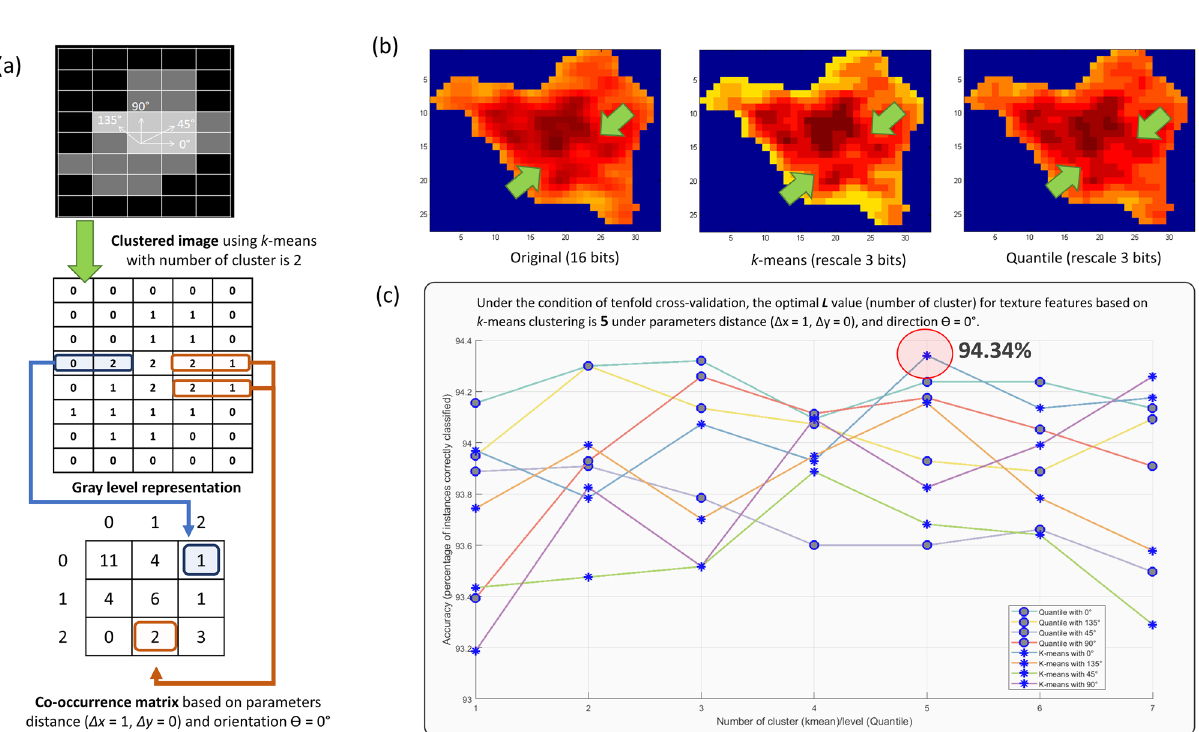
Figure 6. ( a ) Geometrical relationship of GLCM computed based on distance d = 1 and four directions, where Ɵ = 0°, 45° 90°, and 135°. ( b ) The result of texture visualization after rescaling the intensity information from 16 to 3 bits through k -means and the quantile method. ( c ) The optimal k value of k -means and the quantile method determined in the tenfold cross validation experiment using the training